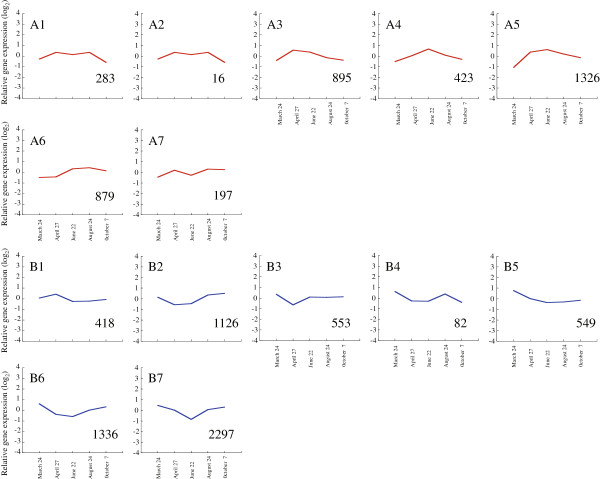
Co-regulation patterns of differentially accumulated transcripts in xylem formation. A total of 10,380 transcripts differentially accumulated in xylem formation were clustered into 14 groups using the Pearson correlation on the Subio platform. The graphs show the average expression profile of each cluster; changes are on a log2 scale. The gene expression pattern is shown as A) upregulation and B) downregulation during xylem formation. The description and expression profile of the individual targets are summarized in Additional file 2.